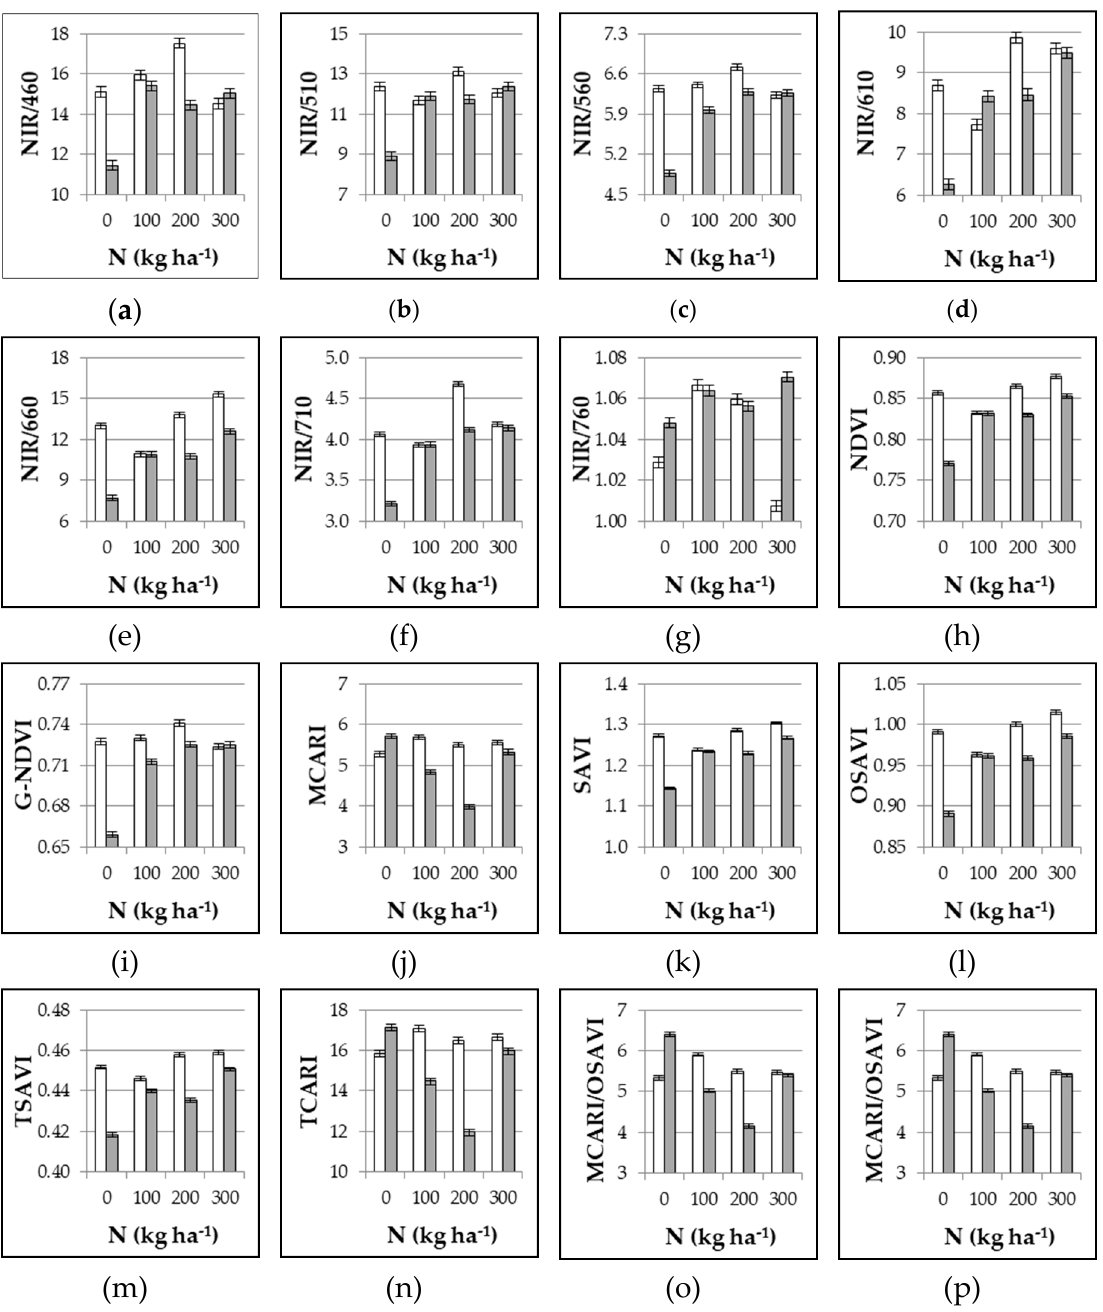
Figure 1. Experiment 1#. Influence of nitrogen supply (0, 100, 200, 300 kg ha − 1 ) and position of multispectral radiometer (0.5 m height white bars, and 1.8 m height grey bars) on different VIs as assessed at 65 DAT. Mean values ± SE.